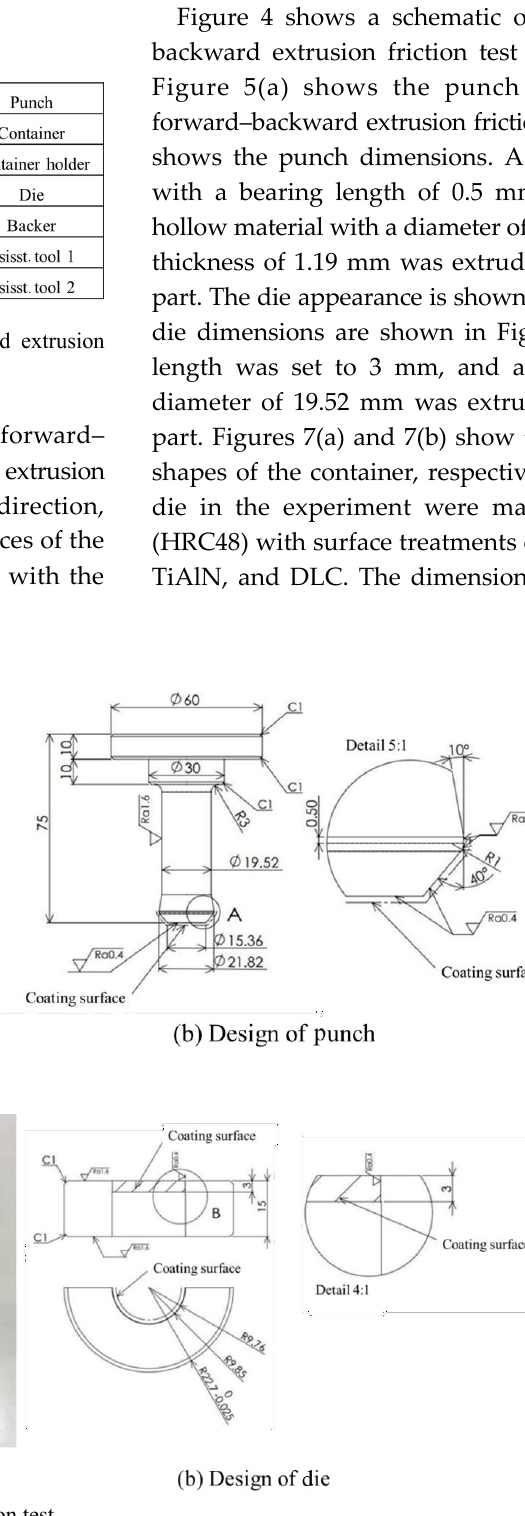
Fig. 6 Segmented die for forward–backward extrusion